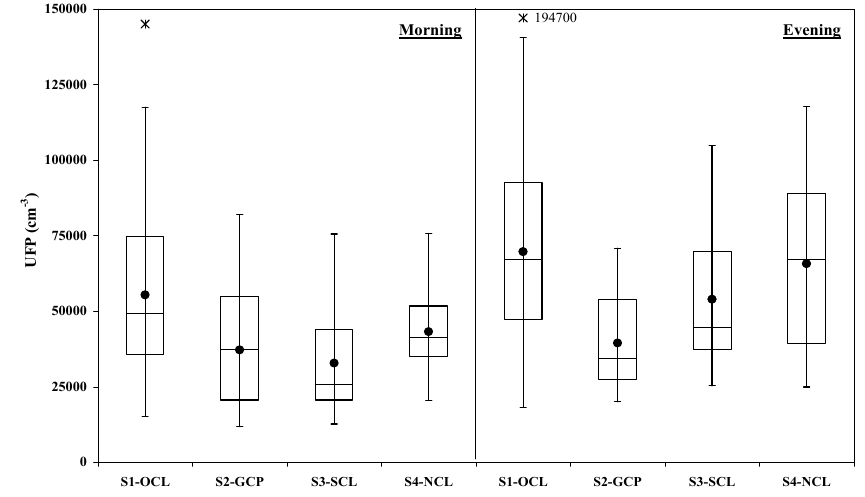
Figure 3. Box-plots of 1-min concentration data for UFP in the cold season (mean values: dots; min-max range: whiskers: median and interquartile range: boxes).